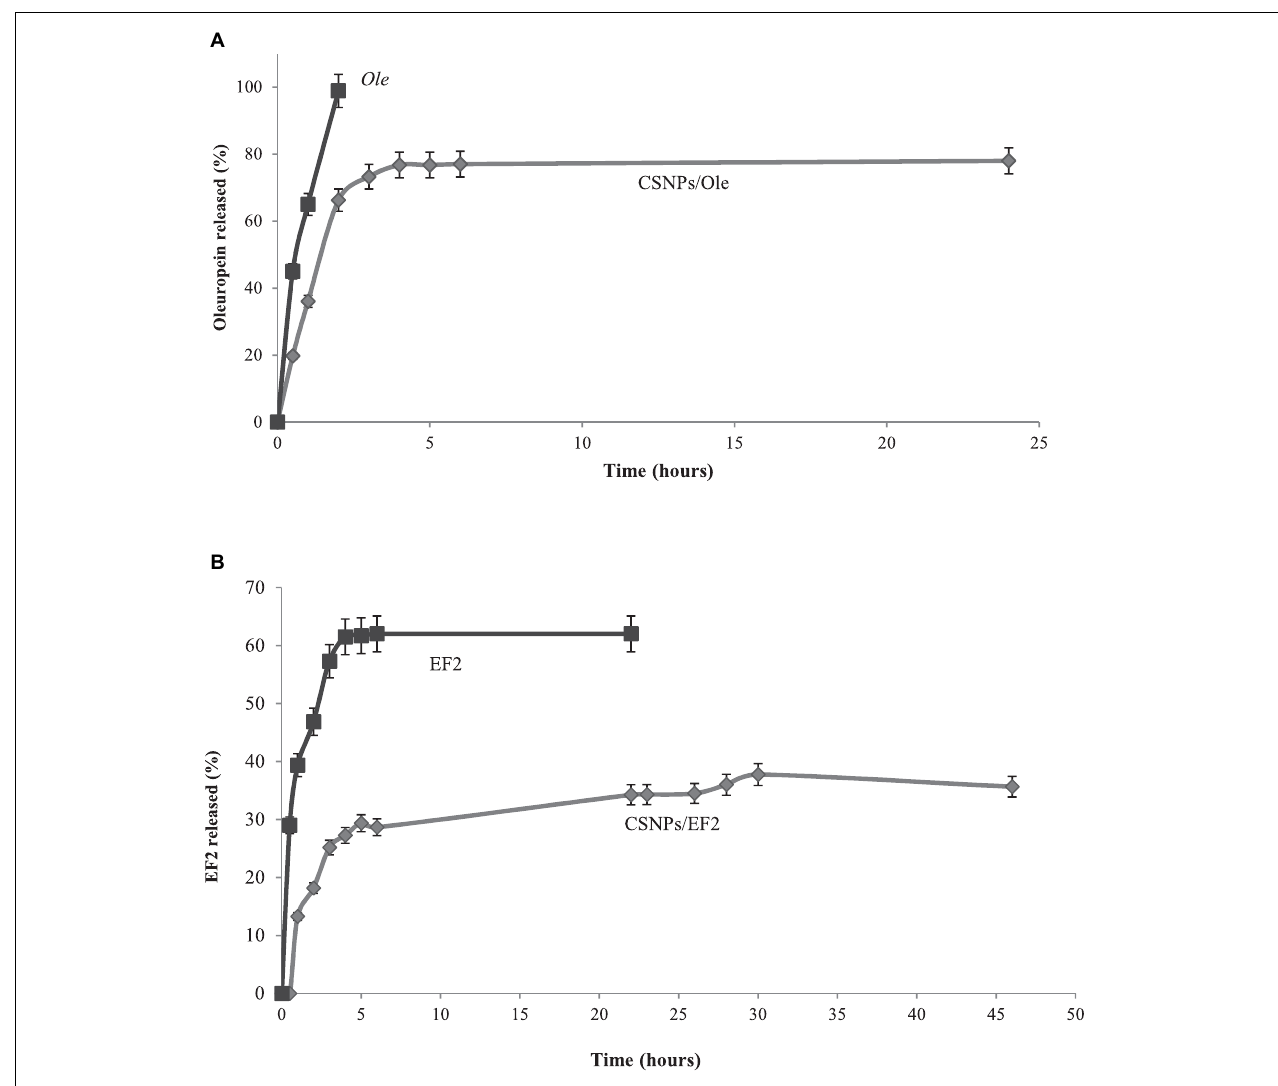
FIGURE 3 | (A) In vitro release profile of the commercial oleuropein in solution ( Ole ) ( (cid:4) ) and in chitosan nanoparticles (CSNPs/ Ole ) ( • ). Data are average ± S.E.M. ( n = 3). (B) In vitro release profile of EF2 leaf extract in solution ( (cid:4) ) and in chitosan nanoparticles (CSNPs/EF2) ( • ). Data are average ± SEM ( n = 3).